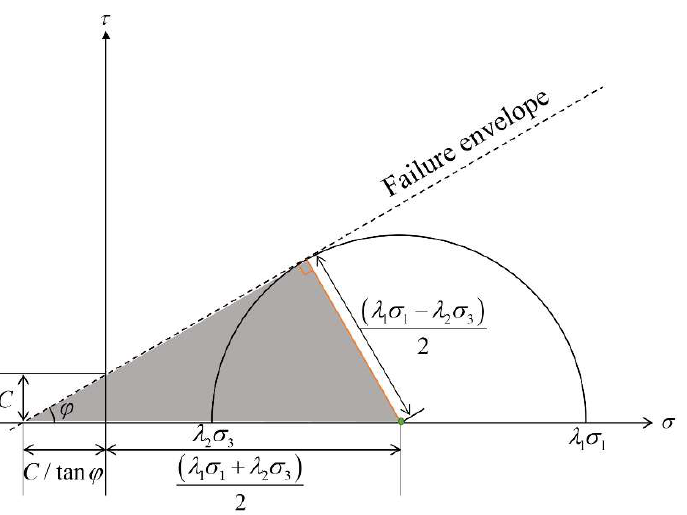
Figure 1. Schematic of critical stress state under influence of water pressure based on Mohr–Coulomb criterion.